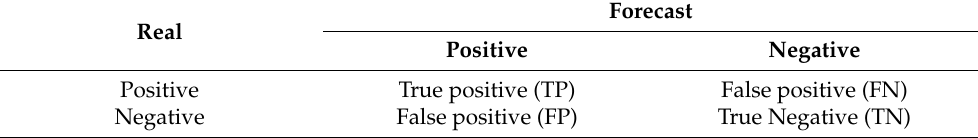
Table 2. Confusion